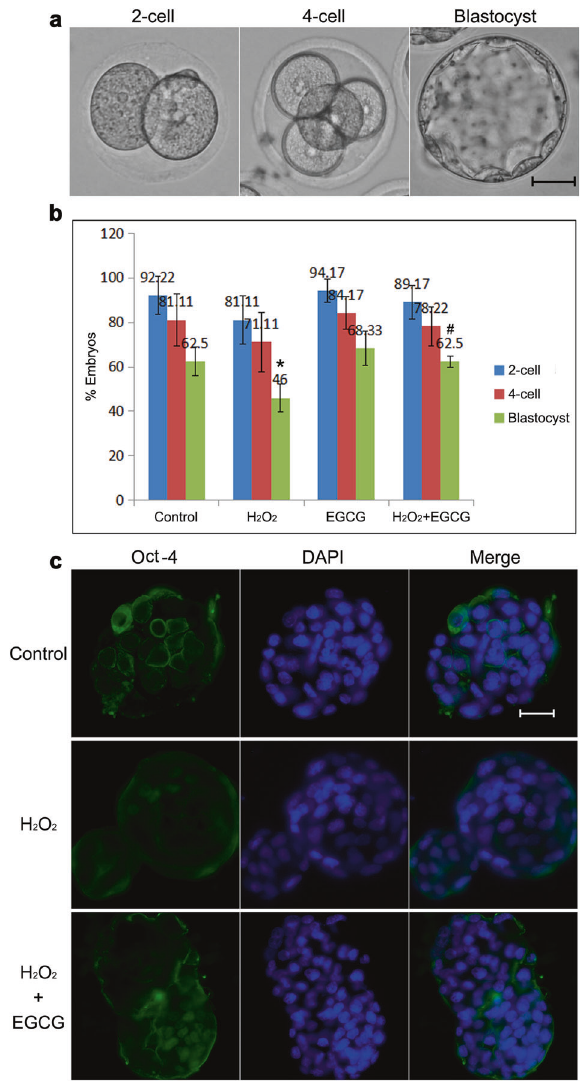
Fig. 2 Developmental arrest in IVF embryos. a Representative images of 2-cell embryos, 4-cell embryos, and blastocysts. Scale bar, 20 μ m. b Rates of 2-cell embryo, 4-cell embryo, and blastocyst formation. Data are expressed as the means ± SDs, collected from three independent experiments, and each experiment had at least fi ve embryos. Differences among groups were analyzed using Student ’ s t test. * P < 0.05 vs. control, # P < 0.05 vs. H 2 O 2 treatment. c Representative fl uorescence micrographs of ICM in blastocysts. The ICM cell number was determined by immuno fl uorescence staining for OCT-4 (green). DAPI staining (blue) was used to analyze the total cell number. Scale bar, 20 μ m.